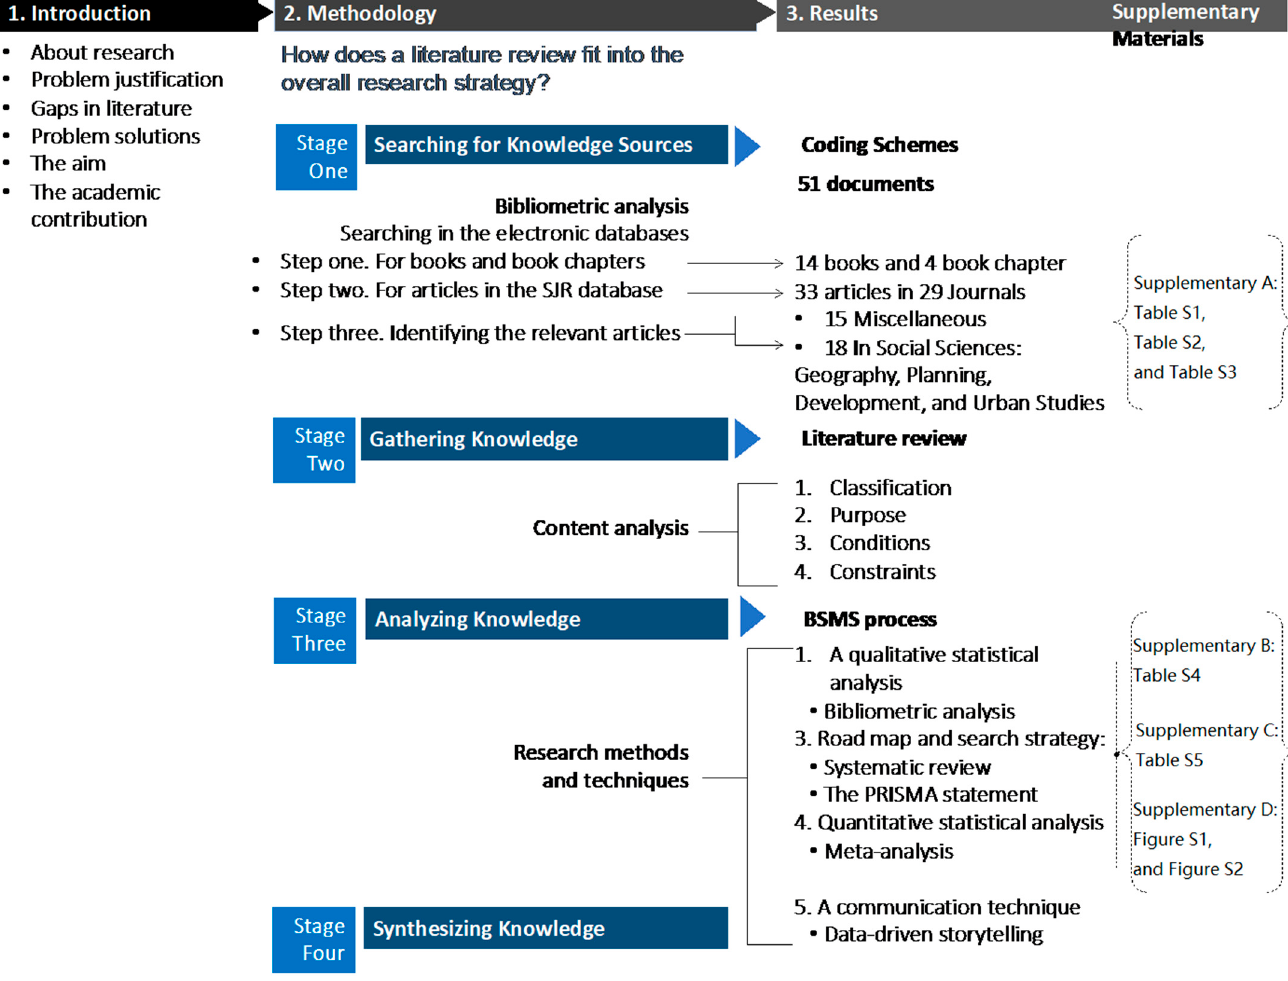
Table 1. The keywords for searching on the relevant books and book chapters.